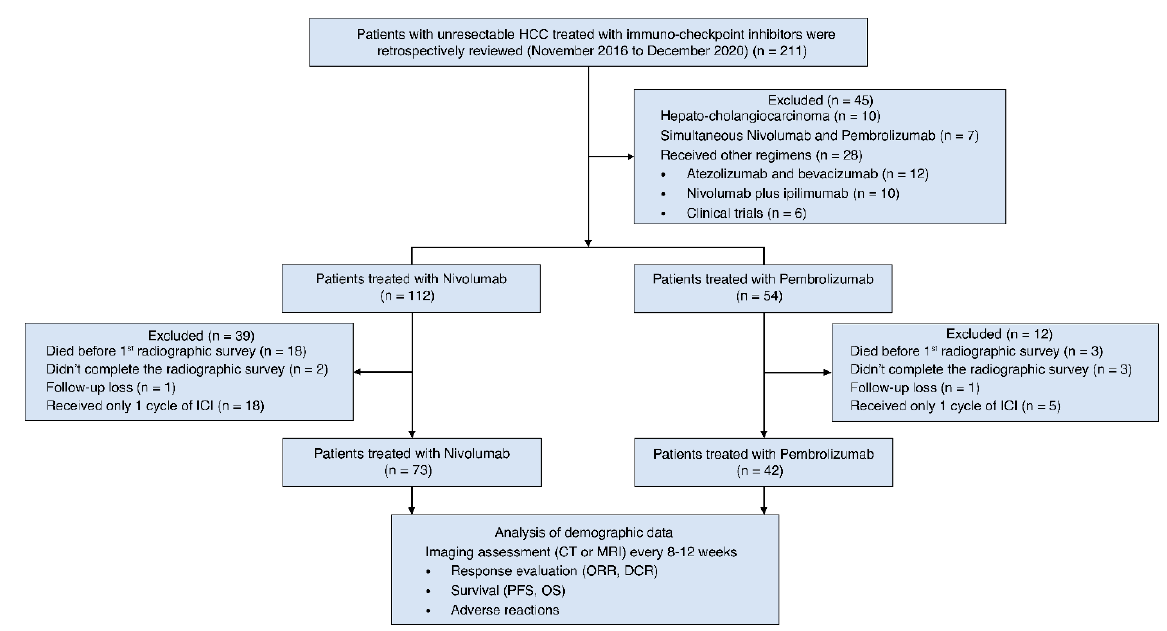
Figure 1. Flow diagram of patient selection. HCC, hepatocellular carcinoma; ICI, immuno-checkpoint inhibitors; CT, computed tomography; ORR, objective response rate; DCR, disease control rate; PFS, progression-free survival; OS, overall survival.